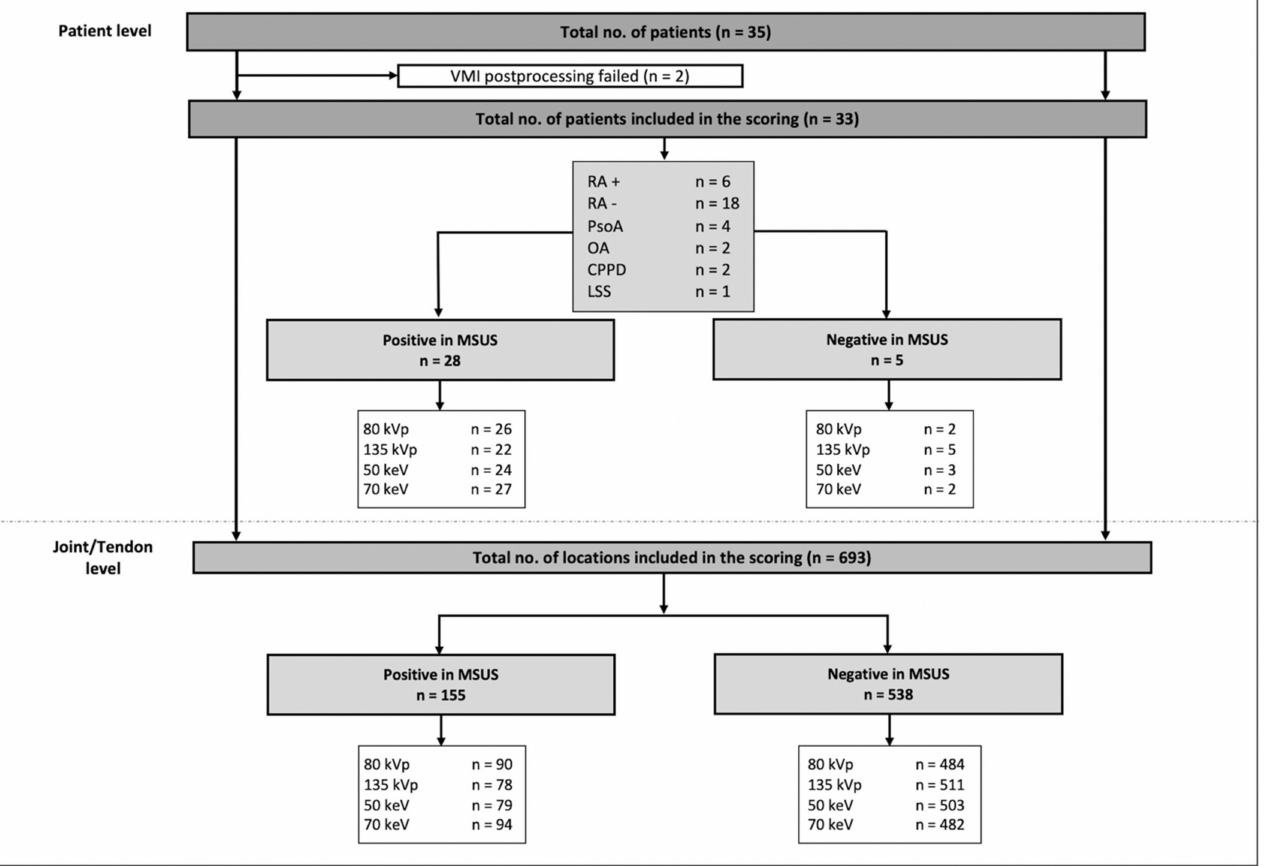
Figure 2. Flowchart of study inclusion and results of the RAMRIS scoring. VMI = virtual monochro- matic imaging, RA+ = seropositive rheumatoid arthritis, RA − = seronegative rheumatoid arthritis, PsoA = psoriatic arthritis, OA = osteoarthritis, CPPD = calcium pyrophosphate deposition disease, LSS = limited systemic sclerosis, MSUS = musculoskeletal